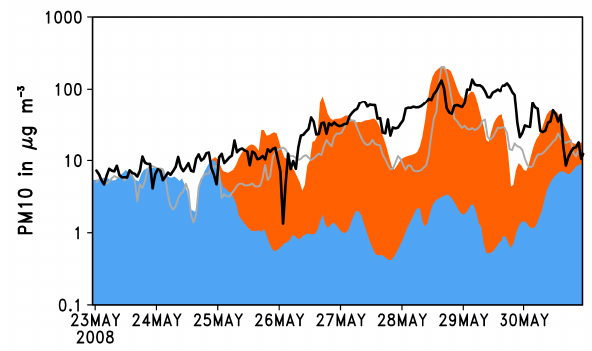
Fig. 3. Measured aerosol mass concentration, PM 10 , at Hohenpeis- senberg (H. Flentje, DWD, personal communication, 2010) (black solid line) and simulated PM 10 of the coarse simulation for do- main D0 (shadings) and the high resolution simulation for domain D1 (gray solid line, simulation CR). Red shading represents the total aerosol mass concentration of dust particles (mode da and db) and blue shading is the total aerosol mass concentration of all other modes (including anthropogenic aerosol particles and sea salt. Please note that the vertical axis is in log 10 -scale to take the large variation of PM 10 during the dust event into